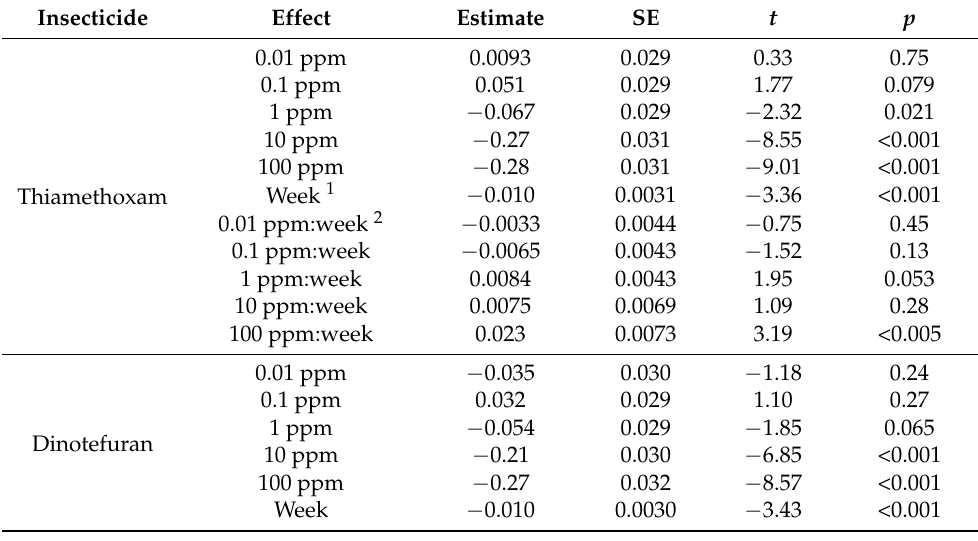
Table A4. Parameter estimates for GLMs to explain the growth rate of Aromia bungii late instar